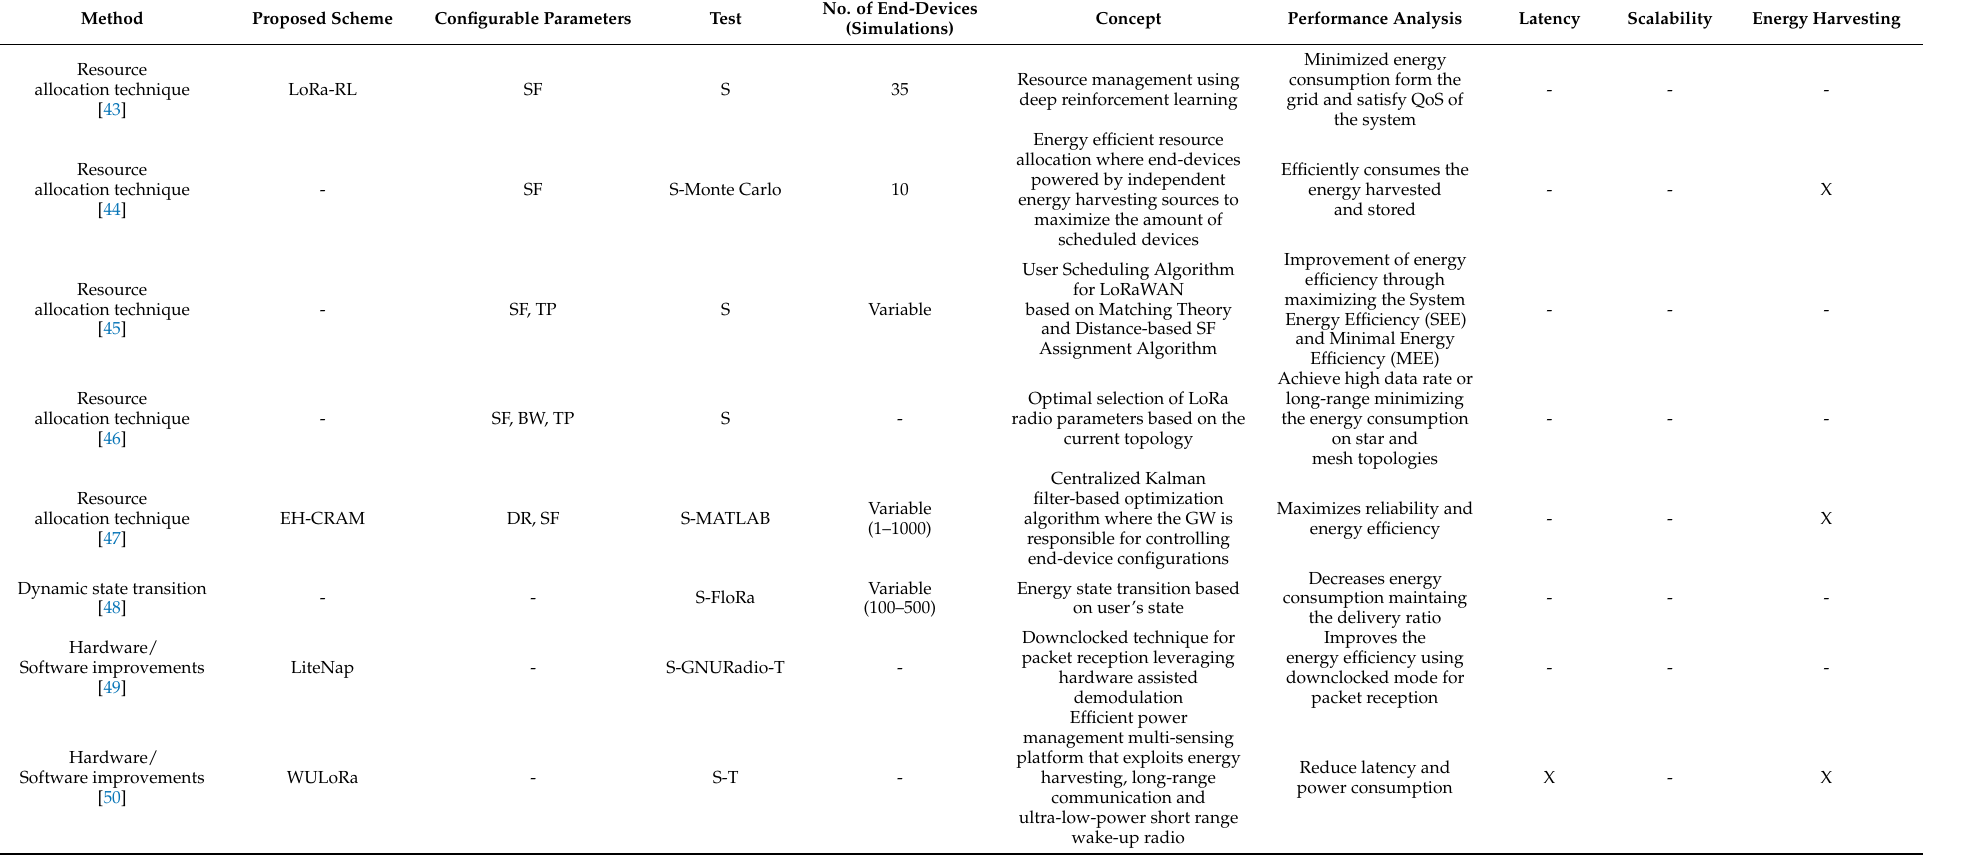
Table 4. Energy efficiency protocols